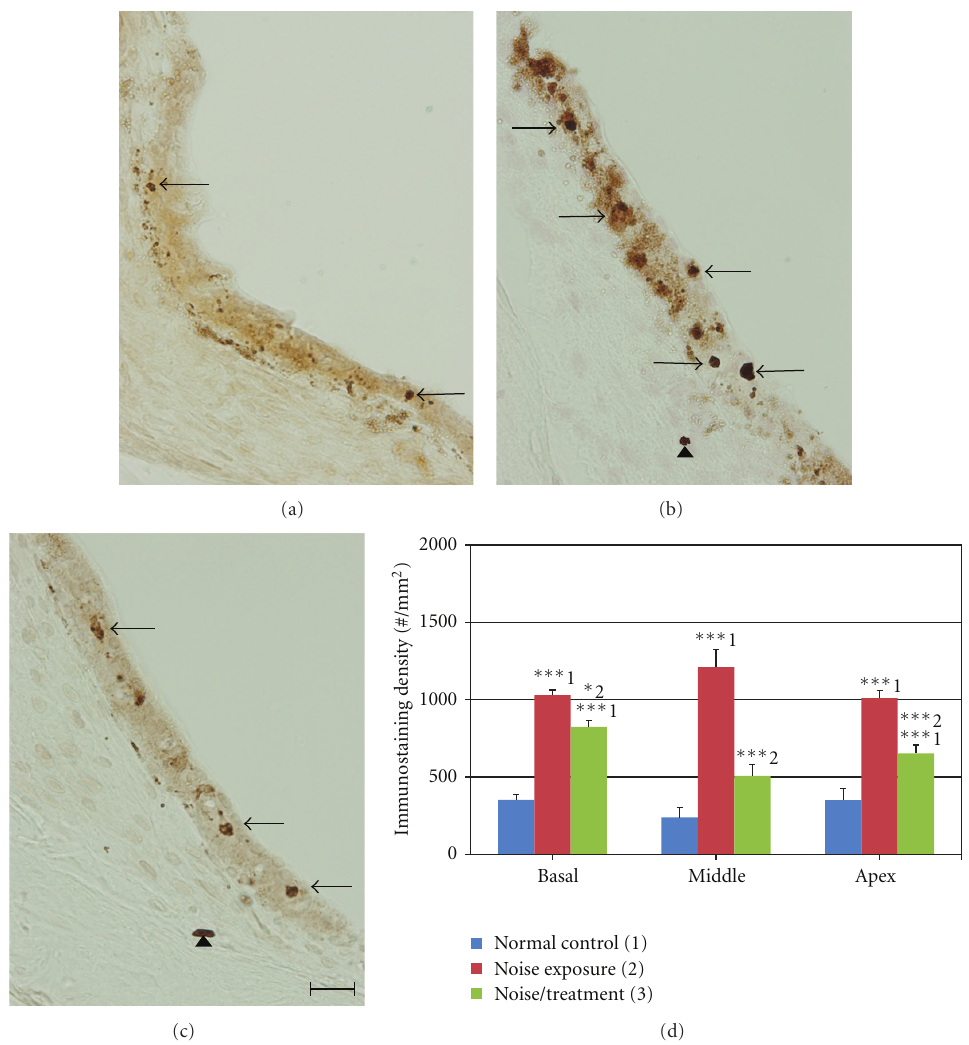
Figure 3: CD45 + immunostaining and immunostaining density in the stria vascularis. Examples of CD45 + immunostaining images obtained from the stria vascularis in the middle turn of cochleae from the normal control (a), noise exposure (b), and noise/treatment (c) groups by light microscopy. Few CD45 + cells were found in the stria vascularis of the normal group (arrows in (a)). There was a large increase in the number of CD45 + cells in the stria vascularis of the noise exposure group (arrows in (b)). The antioxidant treatment significantly decreased the number of CD45 + cells in the stria vascularis (arrows in (c)). CD45 + cells were also found in the spiral ligament of the noise and the noise/treatment groups (arrowheads in b and c), but not in the normal control group. The results of the immunostaining density measurement are shown in (d) (number of cochleae = 6 in each group). There were significant di ff erences among the three groups and in pairwise comparisons in the three groups in each turn. The numbers (1, 2, 3) in (d) indicate the normal control, noise exposure, and noise/treatment groups, respectively. Scale bar = 20 μ m in (c) for (a)–(c) (error bars represent standard error of the means. ∗ , ∗∗ , ∗∗∗ in- dicates P < 0 . 05, 0 . 01, 0.001, resp. Number of cochleae = 6 in each